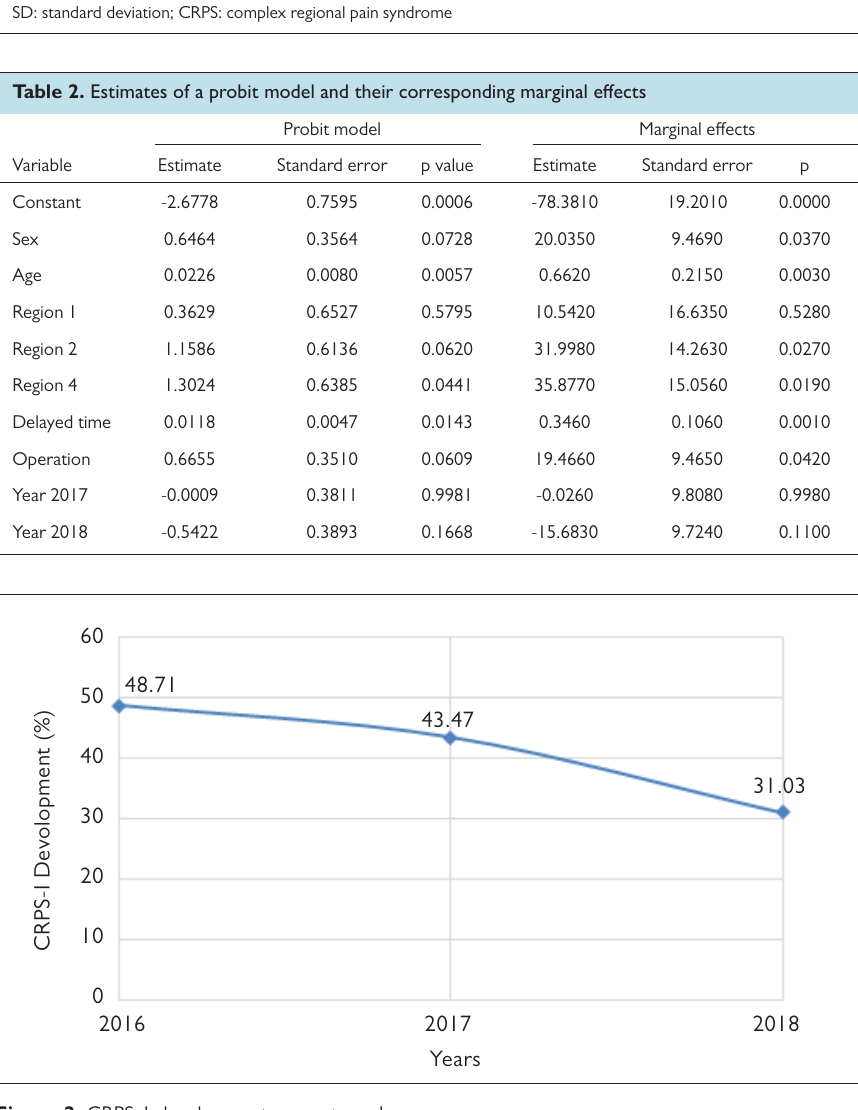
Figure 2. CRPS-1 development percentages by